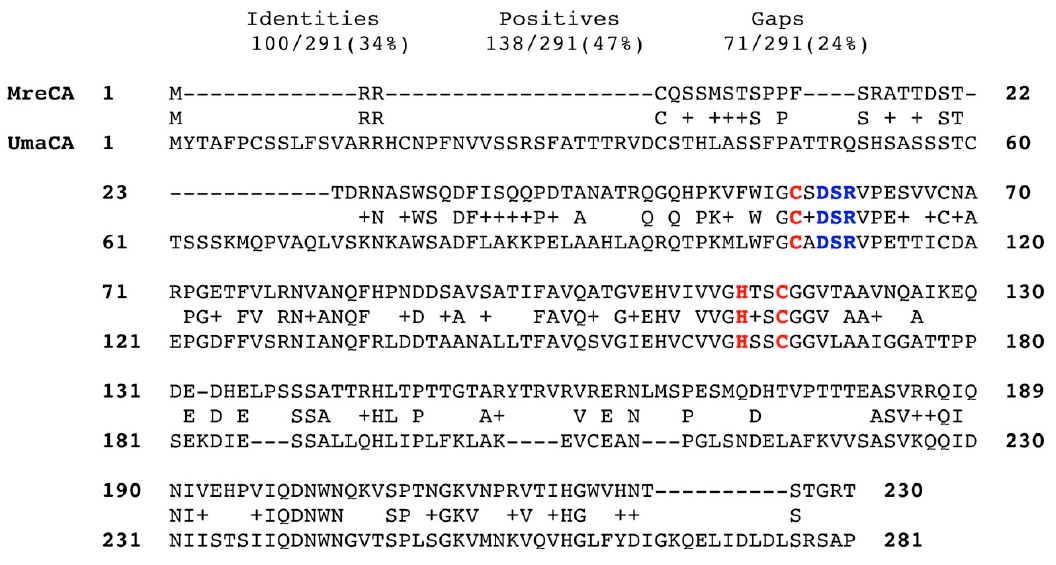
Figure 2. Sequence alignment of the selected β -CAs (MreCA and UmaCA). Zinc ligands are indicated in red; amino acids involved in the enzyme catalytic cycle are indicated in blue. The alignment was performed with the program Blast Global alignment. Legend: MreCA, Malassezia restricta β -CA; UmaCA, Ustilago maydis β -CA; + symbol, indicates the residues with the same biochemical properties; - symbol, represents the gaps between the amino acid residues.